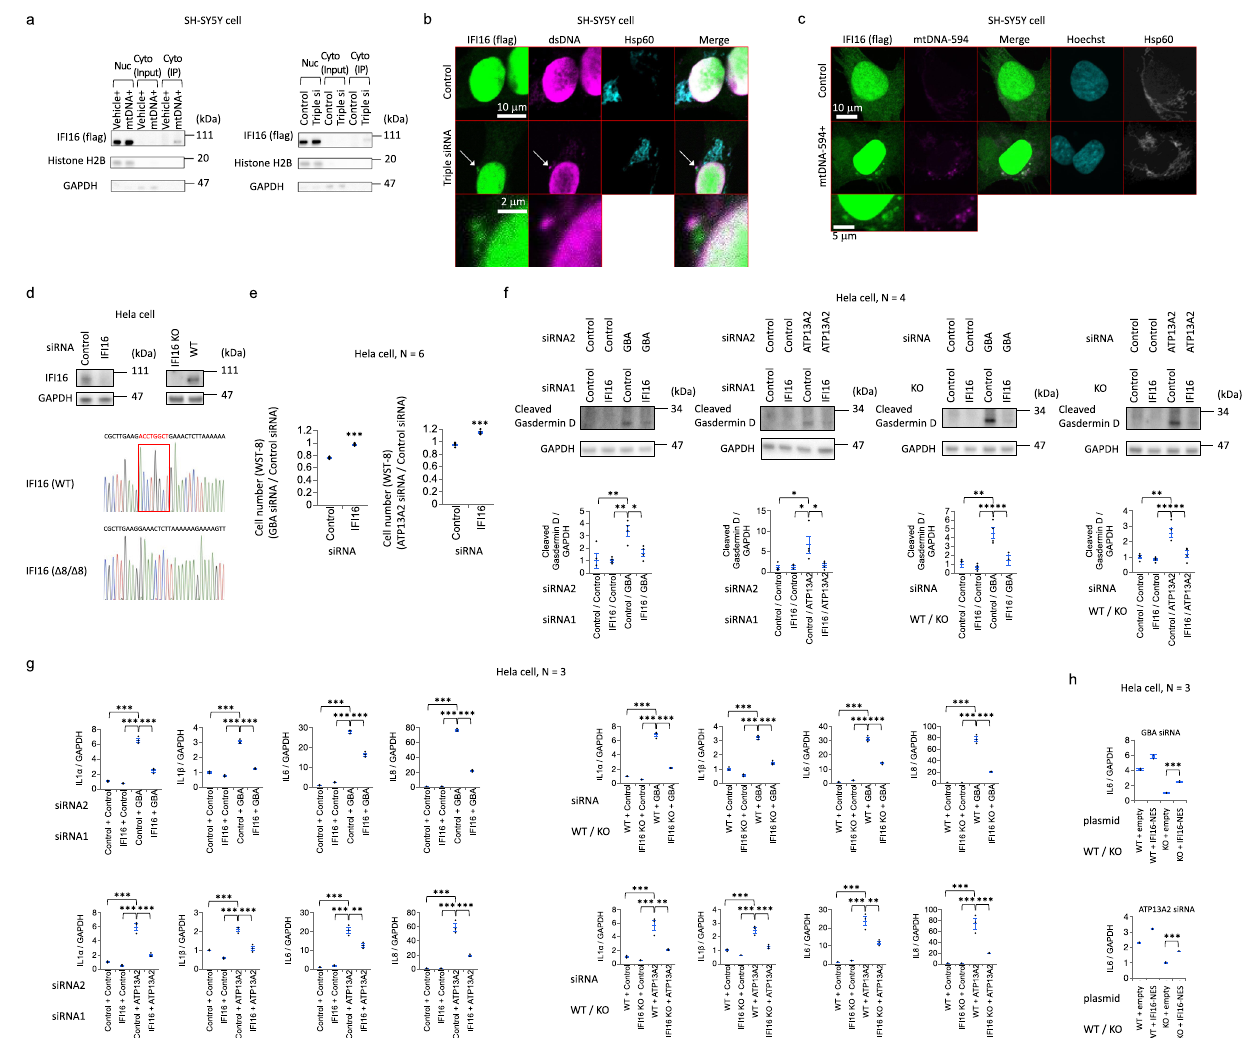
Fig. 3 Effects of IFI16 on the cytotoxicity induced by cytosolic dsDNA of mitochondrial origin. a SH-SY5Y cells in which mitochondrial DNA was introduced (left fi gures) or GBA, ATP13A2, and PINK1 were depleted (right fi gures) were subjected to immunoprecipitation using an anti-dsDNA antibody. The immunoprecipitation results show an interaction between cytosolic dsDNA of mitochondrial origin and fl ag-tagged IFI16 (IFI16- fl ag). Nuc: Nuclear fraction. Cyto: Cytosolic fraction. Triple si: Knockdown of GBA, ATP13A2, and PINK1 expression with siRNAs. IP: Immunoprecipitation. b Colocalization of cytosolic dsDNA and IFI-16- fl ag in GBA-, ATP13A2-, and PINK1-depleted SH-SY5Y cells. Triple siRNA: Knockdown of GBA, ATP13A2, and PINK1 expression with siRNAs. c Colocalization of exogenous mitochondrial DNA conjugated with Alexa Fluor 594 and IFI-16- fl ag in SH-SY5Y cells. mtDNA-594: mitochondrial DNA conjugated with Alexa Fluor 594. d siRNA knockdown of IFI16 in HeLa cells and establishment of IFI16 knockout HeLa cells. Western blotting targeting endogenous IFI16 and the genome sequence show a homologous 8 bp deletion resulting in the complete loss of the IFI16 protein. WT: Wild type. e Effect of IFI16 depletion on cell viability (WST-8 assay) in GBA- or ATP13A2-depleted HeLa cells. f Effect of IFI16 depletion (siRNA knockdown or knockout) on cleaved Gasdermin D in HeLa cells with GBA or ATP13A2 knockdown. g Effect of IFI16 depletion (siRNA knockdown or knockout) on type I IFN responses in HeLa cells with GBA or ATP13A2 knockdown. qPCR results for IL-1 α , IL-1 β , IL-6, and IL-8 mRNAs are shown. h Effect of IFI16 overexpression in the cytosol (MAPKK nuclear export signal (NES)-tagged IFI16) on type I IFN responses in IFI16 knockout HeLa cells with GBA or ATP13A2 knockdown. qPCR results for IL-6 mRNAs are shown. The statistical details are described in Supplementary Table 4. Source data of Fig. 3 are provided as a Source Data fi